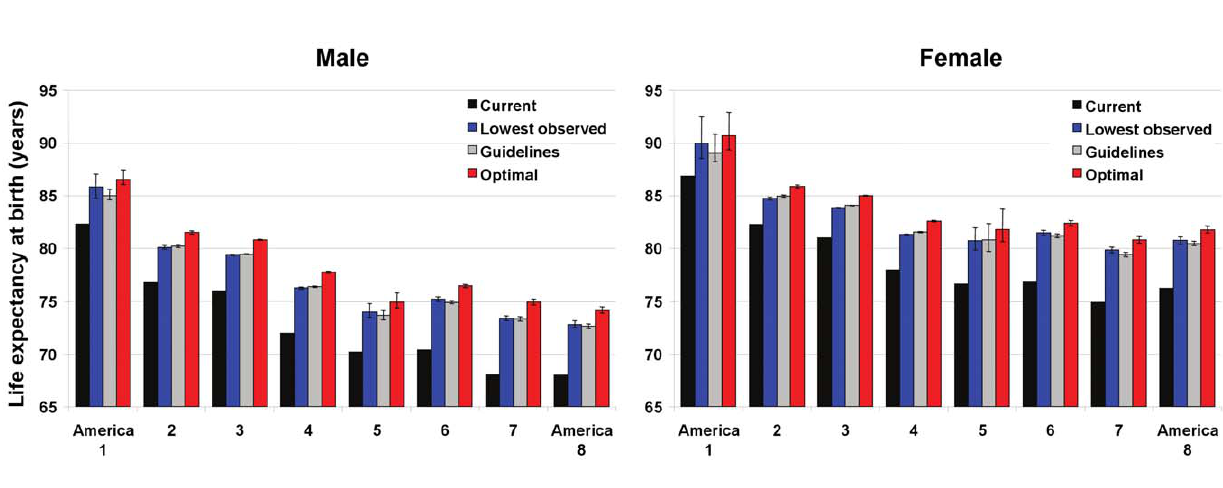
Figure 1. Current life expectancy at birth and life expectancy under three alternative risk factor distributions in the Eight Americas for men and women. See definitions of the Eight Americas in Table 1. The means and 95% confidence intervals for life expectancy under the three alternative distributions was estimated using simulations as described in Methods. Because the number of simulations was finite, the means may be slightly different from the numbers reported in Table 4 and the text. This difference is in the order of 0.1% and does not affect our conclusions.